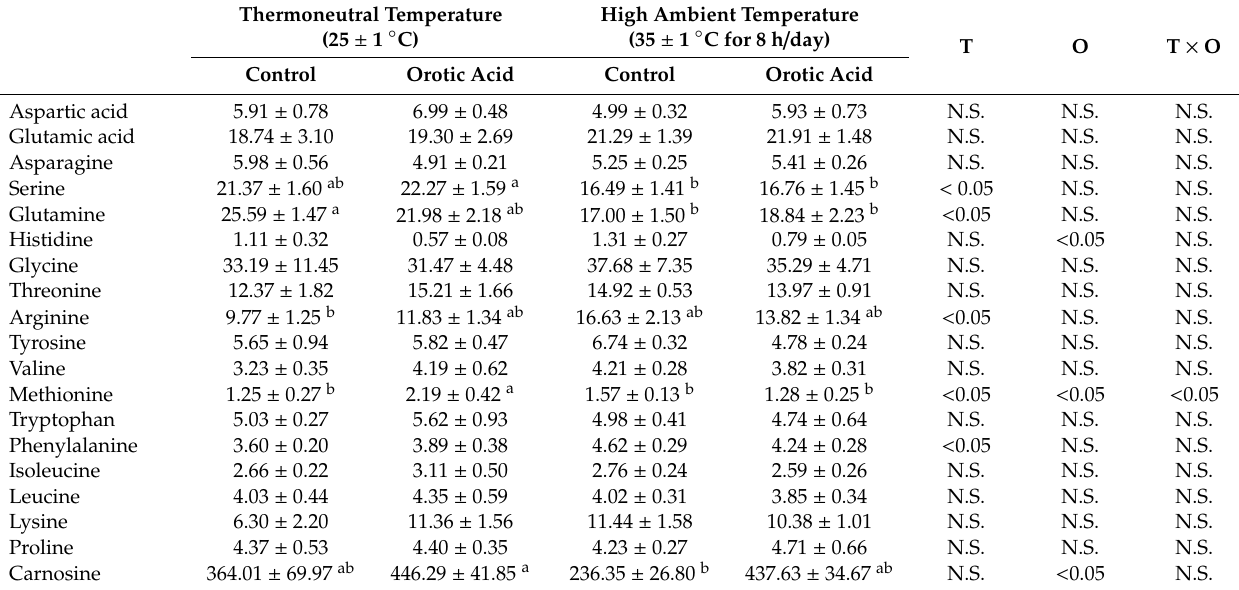
Table 6. E ff ects of a cyclic high ambient temperature and feeding orotic acid on free amino acids and carnosine in the breast muscle of broiler chickens (mg / 100